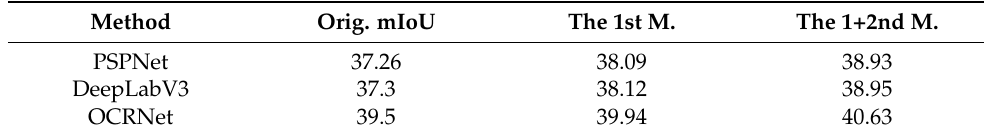
Table 4. Experimental results on the COCO-Stuff